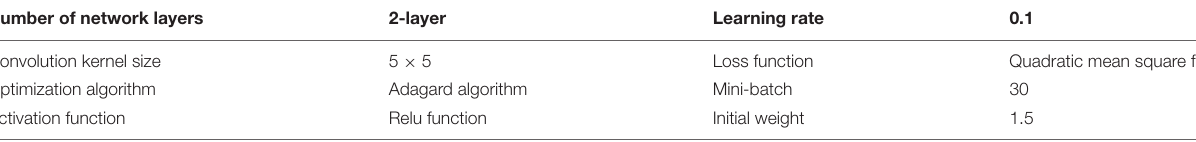
TABLE 1 | CNN parameter setting.